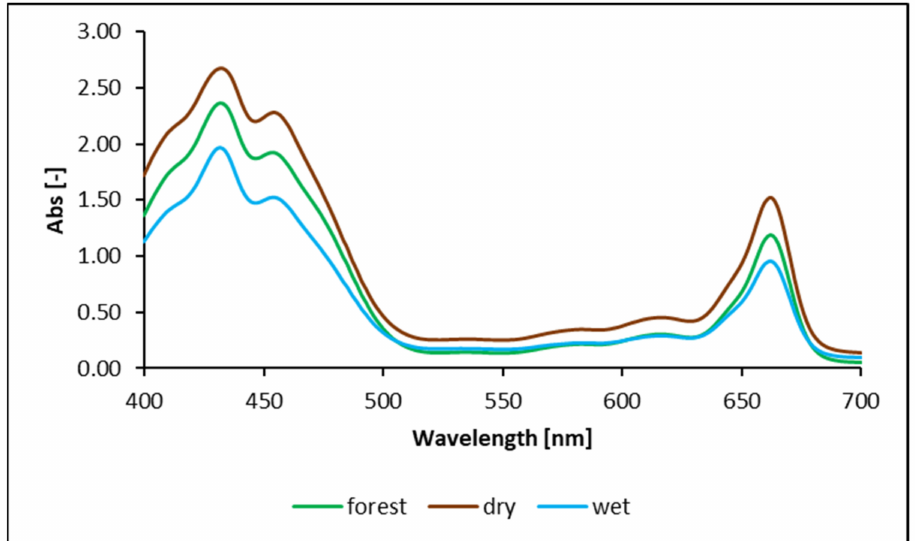
Figure 2. Photoabsorption spectra of pigment from the moss